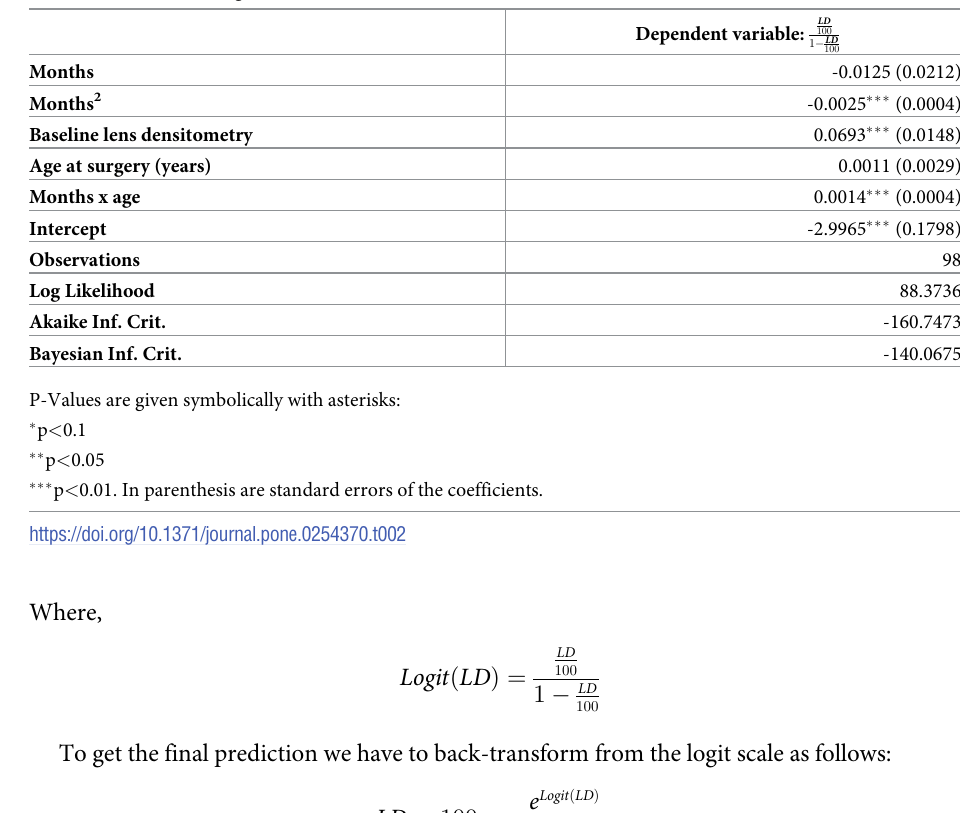
Table 2. Mixed effects regression model